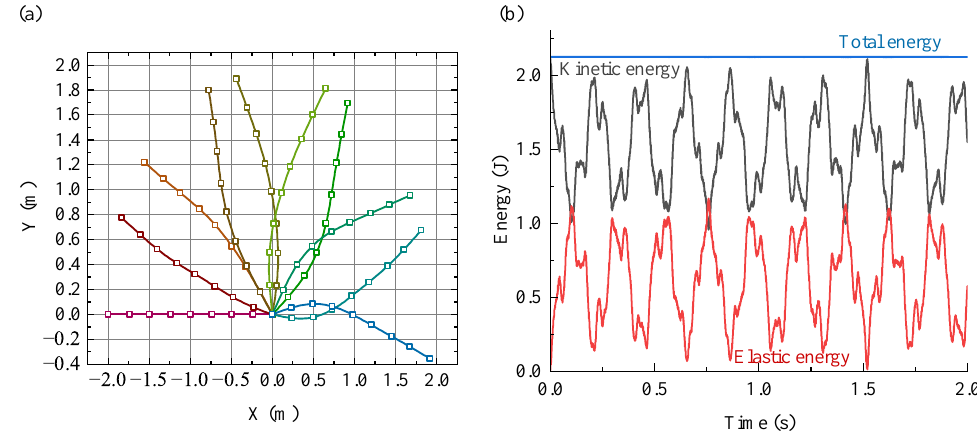
Figure 5. The dynamic simulation of example-2. ( a ) The spatial state of motion of the left end rope at the center point. ( b ) The energy conservation in double-ended shock